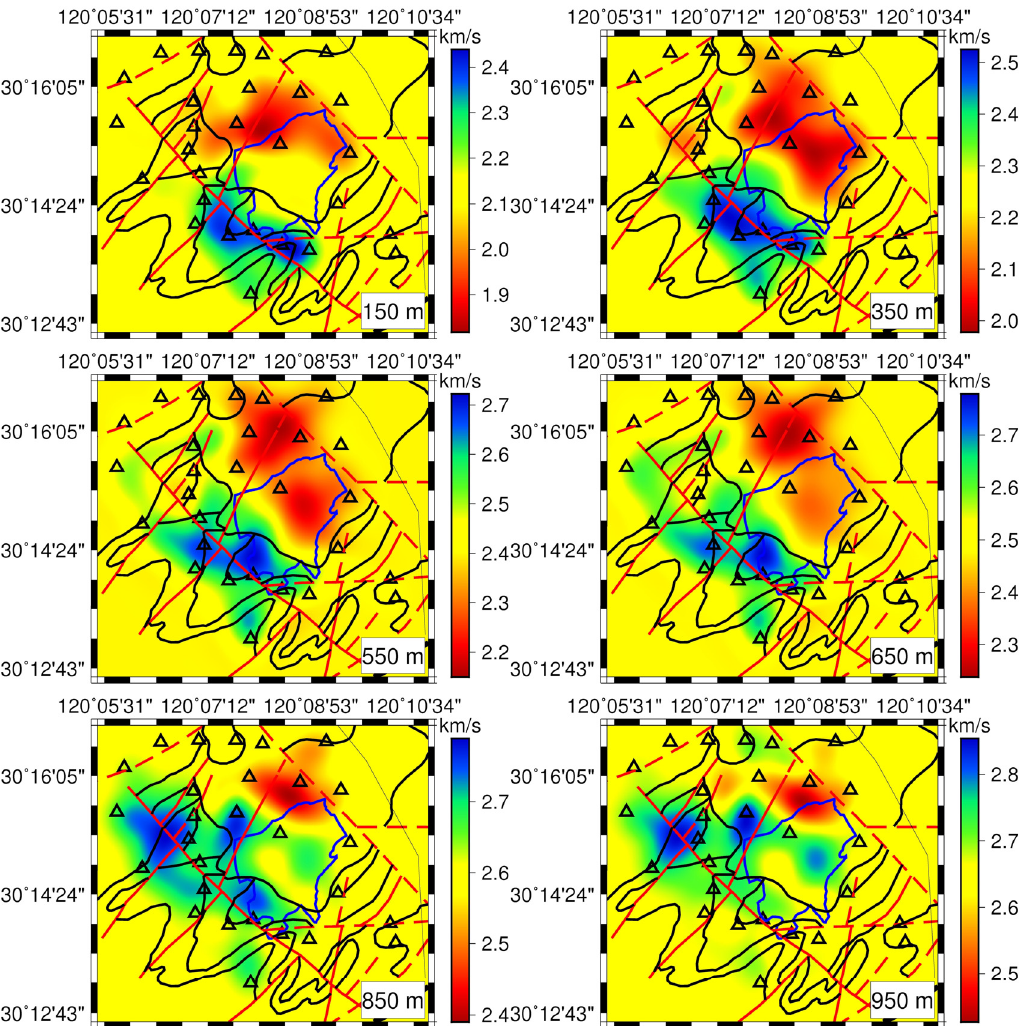
Figure 10. The depth slices from the joint inversion of both group- and phase-velocity